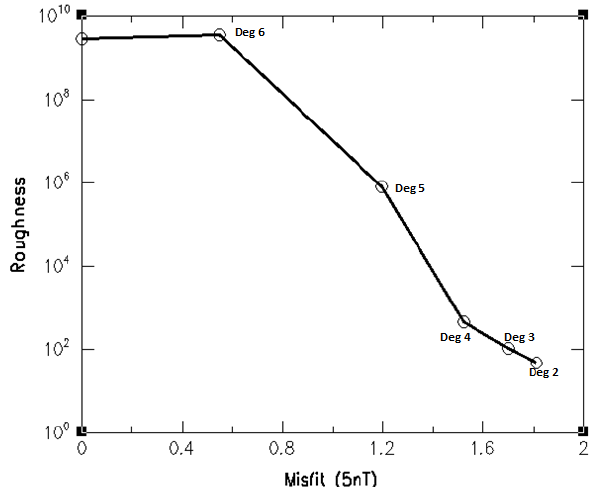
Figure 9. Plot of roughness against misfit of spherical harmonic degree truncation ( n = 2, 3, 4, 5 and 6). The roughness gives you a measure of when the data–model misfit starts to go wrong, which is at n >